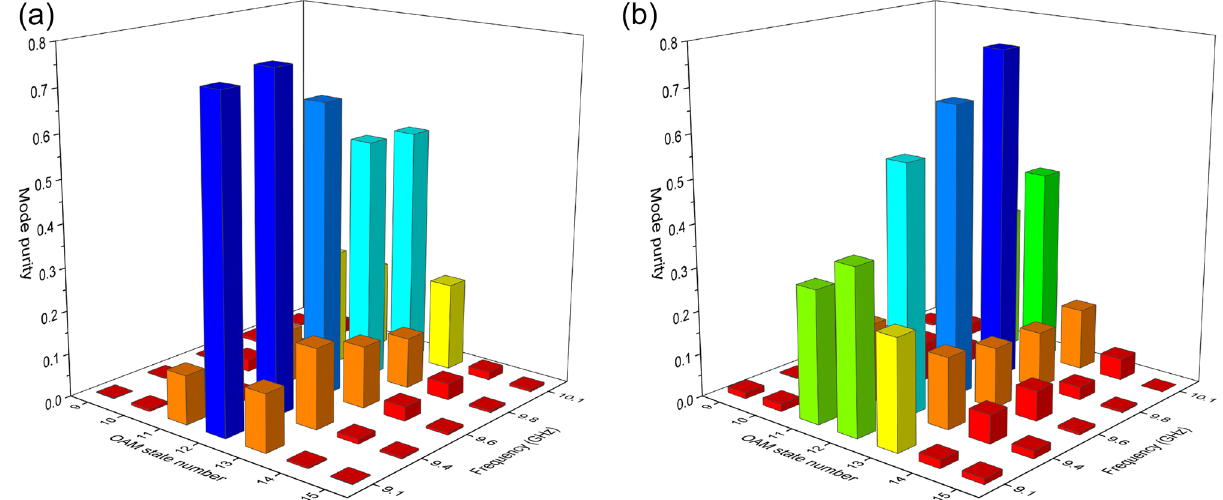
Figure 6. The normalized mode purity of the beam emitted from the proposed OAM antenna. ( a ) The modal content calculated through simulated phase data. ( b ) The modal content calculated through measured phase data.